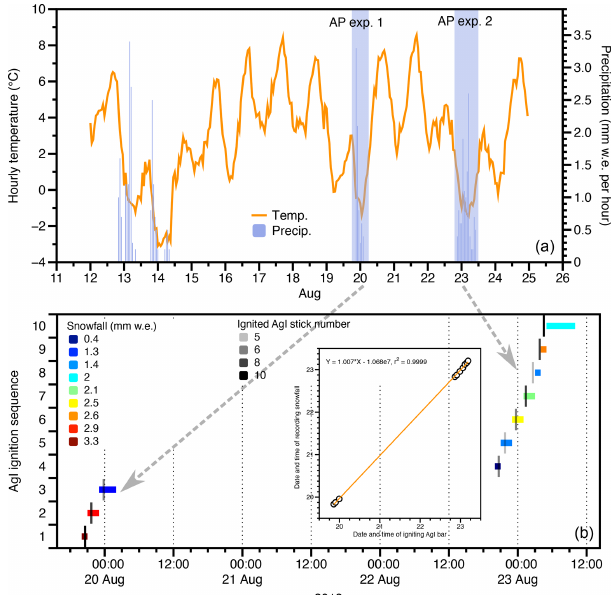
Figure 5. (a) The daily snowfalls and hourly averaged temperature recorded by the AWS at ELA from 12 to 24 August 2018, where the two artificial precipitation experiments (AP experiment 1 and 2) are marked. (b) The hourly snowfall amounts (indicated by colour) and time periods (indicated by length) recorded by the AWS at ELA and the ignited AgI stick number (indicated by colour) and time during the two experiments.